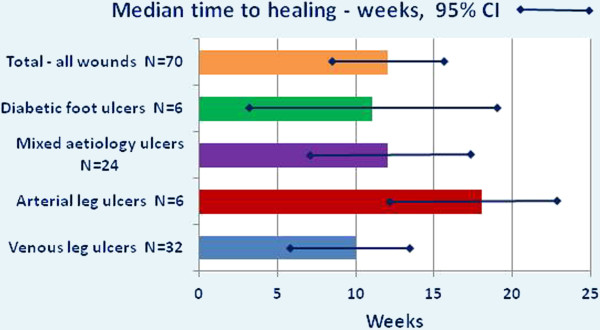
Median time to healing by ulcer type.